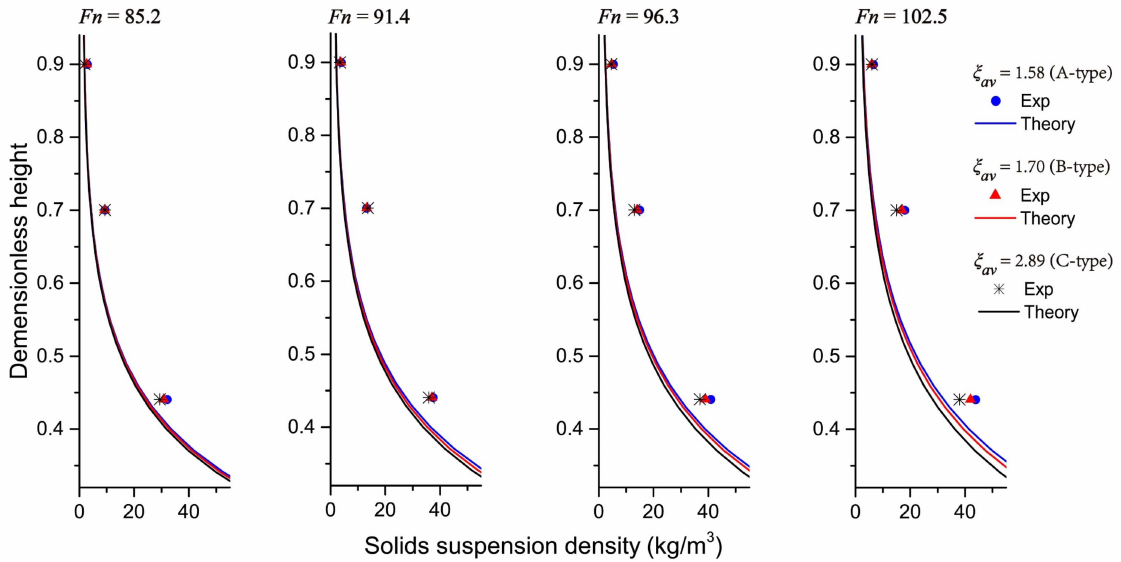
Figure 12. Effect of superficial velocity on suspension density with different ξ av .